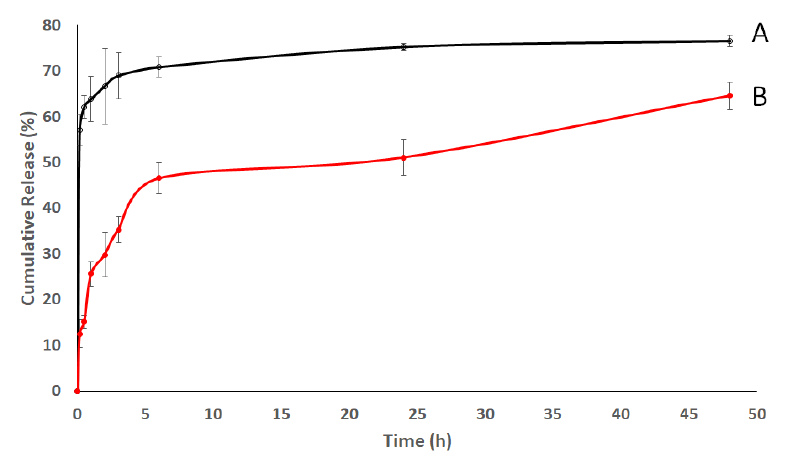
Figure 4. Time-dependent release profiles of ( A ) AA and ( B ) HARF–HPßCD complex from HARF–HPßCD/AA@PLGA-PEG NPs at 37 °C into phosphate-buffered saline.